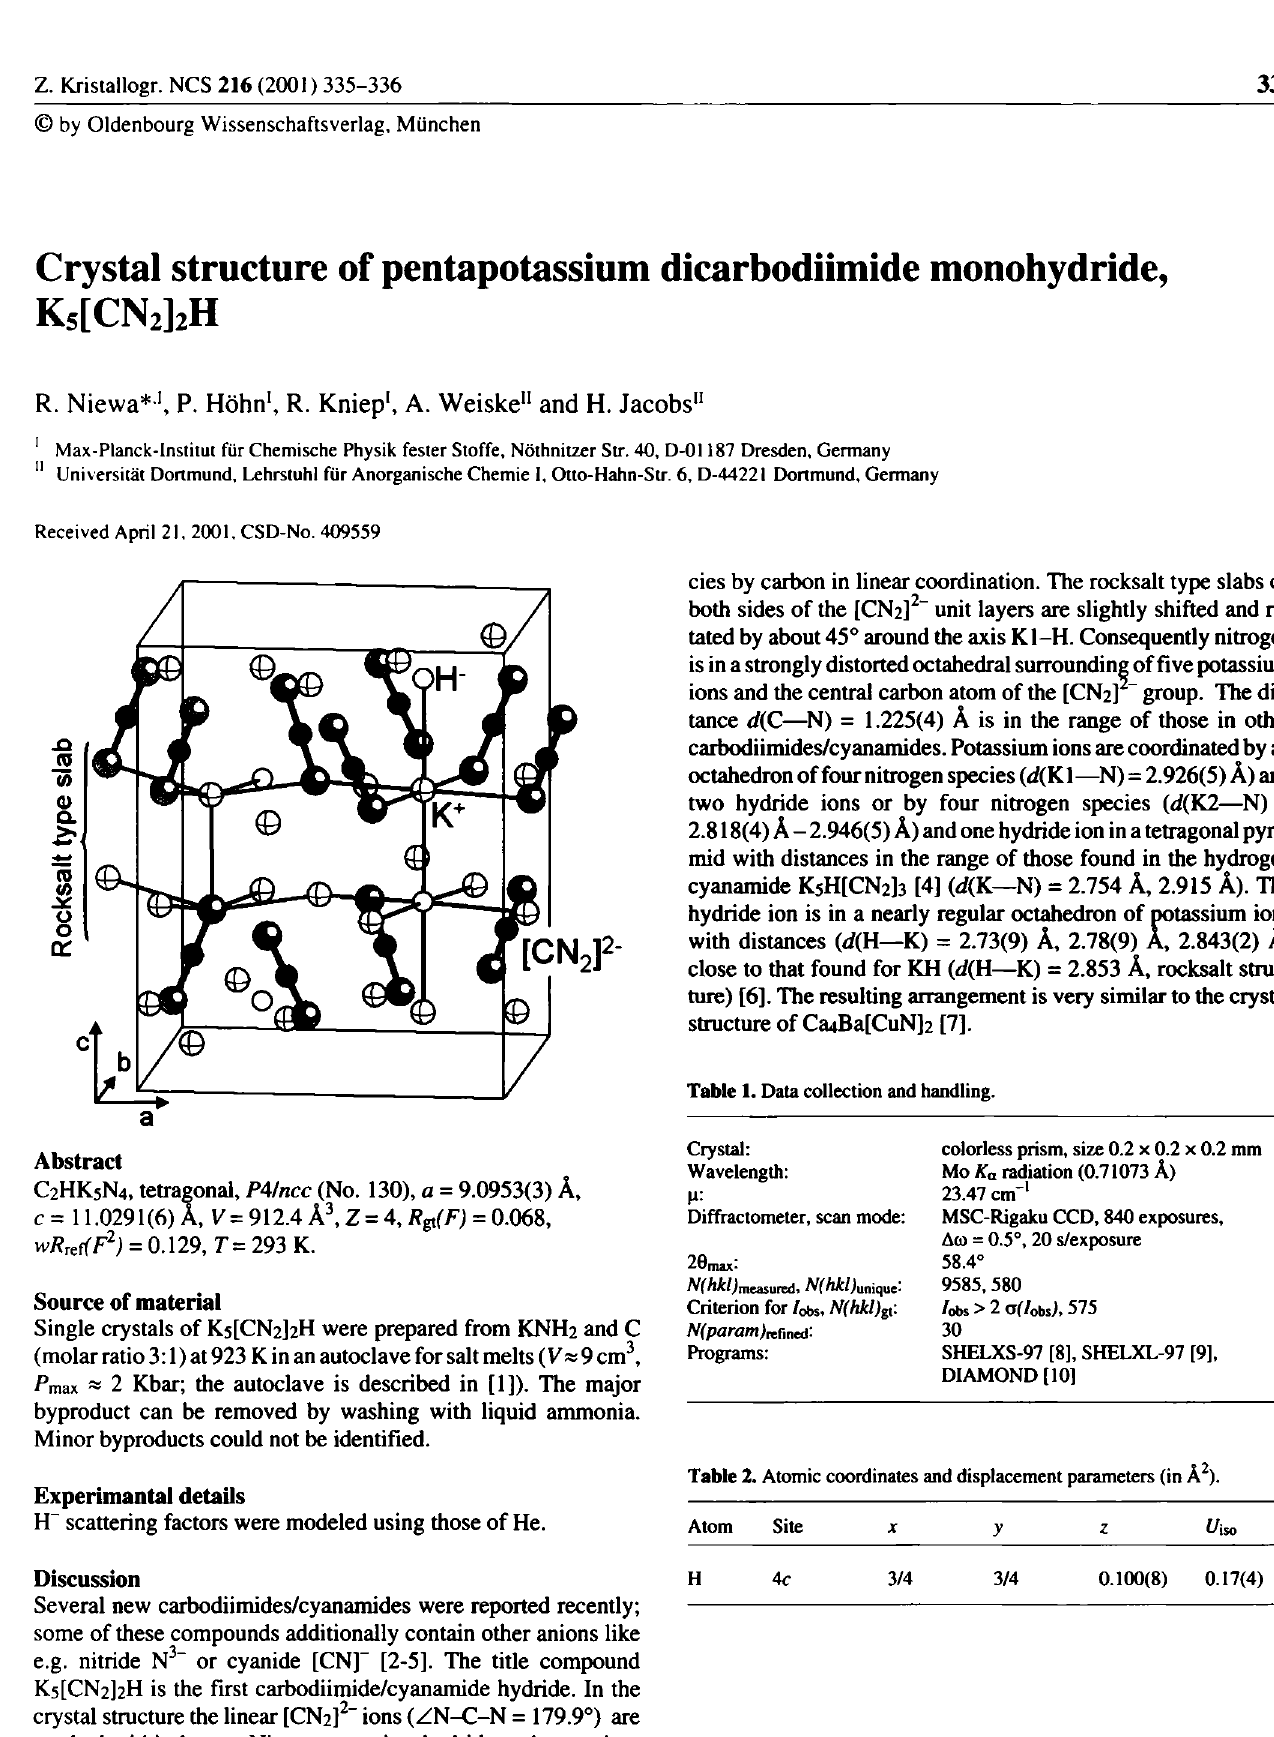
Table 2. Atomic coordinates and displacement parameters (in A 2